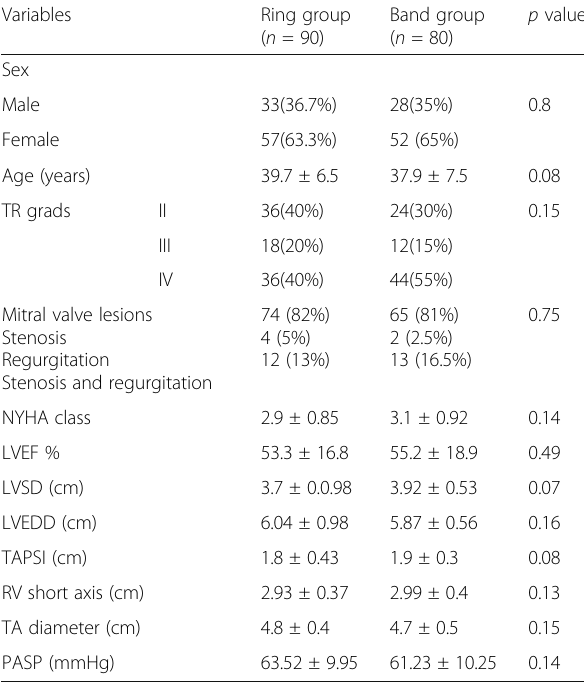
Table 1 Preoperative data in both study